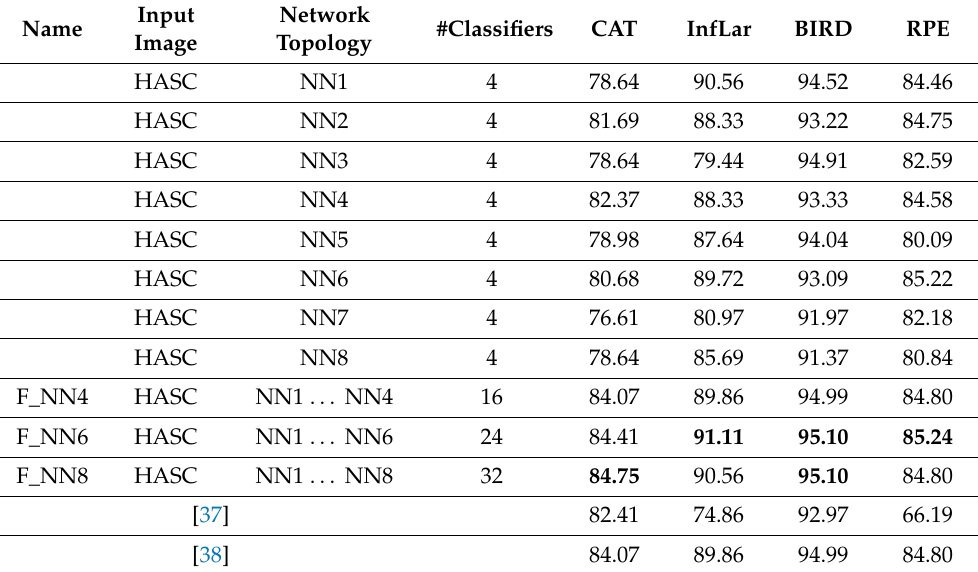
Table 2. Performance accuracy obtained considering different network topologies with HASC input images. Best values are in bold-faced.